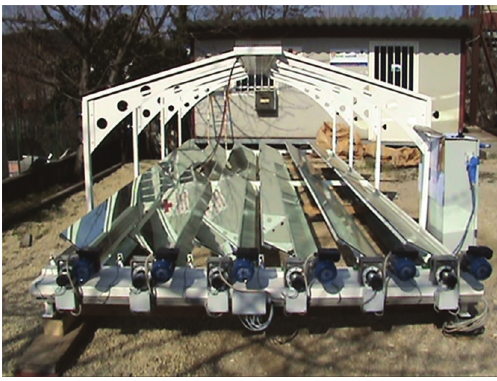
Figure 1: The innovative PV low-concentration